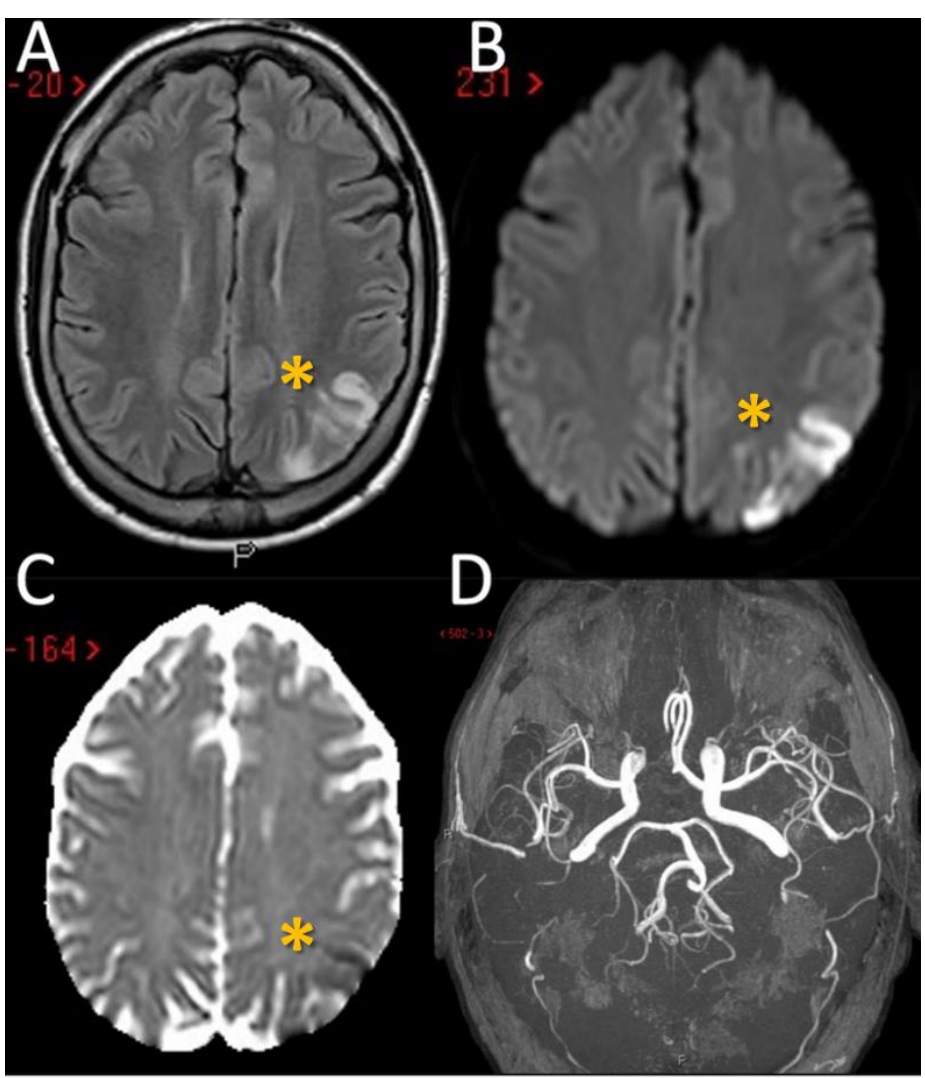
Figure 1. Brain MRI of the first patient. MRI of patient 1 showed the presence in the axial Fluid Attenuated Inversion Recovery (FLAIR) sequences of a wedge of cortical ischemic lesions in the left posterior parietal lobe (yellow asterisk) ( A ) with DWI and ADC sequences pattern suggesting acute ischemic lesions ( B , C ). MRA (time-of-flight [TOF] reconstruction) shows fully patent proximal intracranial arteries and right A1 anterior cerebral artery (ACA) aplasia ( D ). MRI: Magnetic Resonance Imaging; MRA: Magnetic Resonance Angiography; DWI: Diffusion Weighted; ADC: Apparent Diffusion